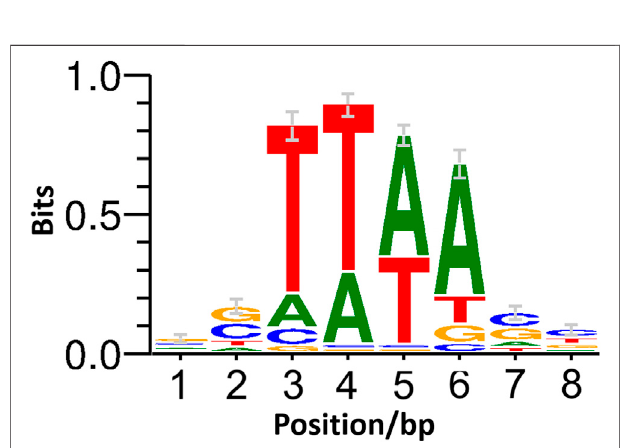
FIGURE 4 | Weblogo of the IS Cg1 target site. WebLogo (Crooks, 2004) of the IS Cg1 target site based on the strand-speci fi c 8 bp of genomic sequence downstream of the inverted repeat at transposition sites with at least two mapped